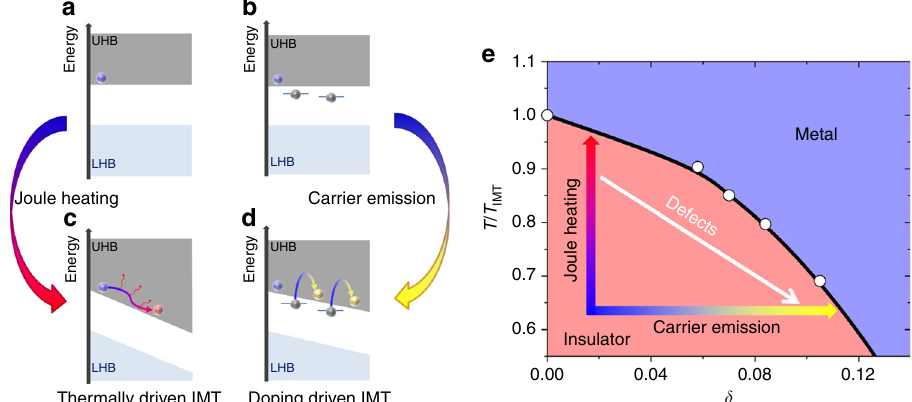
Fig. 4 Two routes for resistive switching in a Mott insulator. a – d Schematic representation of Joule heating and fi eld-driven IMT switching in a Mott insulator. In a system with no defects a , only a small number of thermally activated carriers are present in the upper Hubbard band (UHB). Application of a strong electric fi eld, depicted as strong band tilt c , accelerates these carriers causing Joule heating due to scattering. In a system with defects b , a moderate electric fi eld promotes carriers from in-gap states into the UHB d resulting in collapse of the Mott insulator state via a doping-driven IMT. e Phase diagram of the single band Hubbard model based on DMFT calculations. The colored arrows schematically denote the two possible routes towards the metallic phase when applying electric fi eld as discussed in a – d . Defects increase the effectiveness of carrier emission and facilitate a doping driven non- thermal